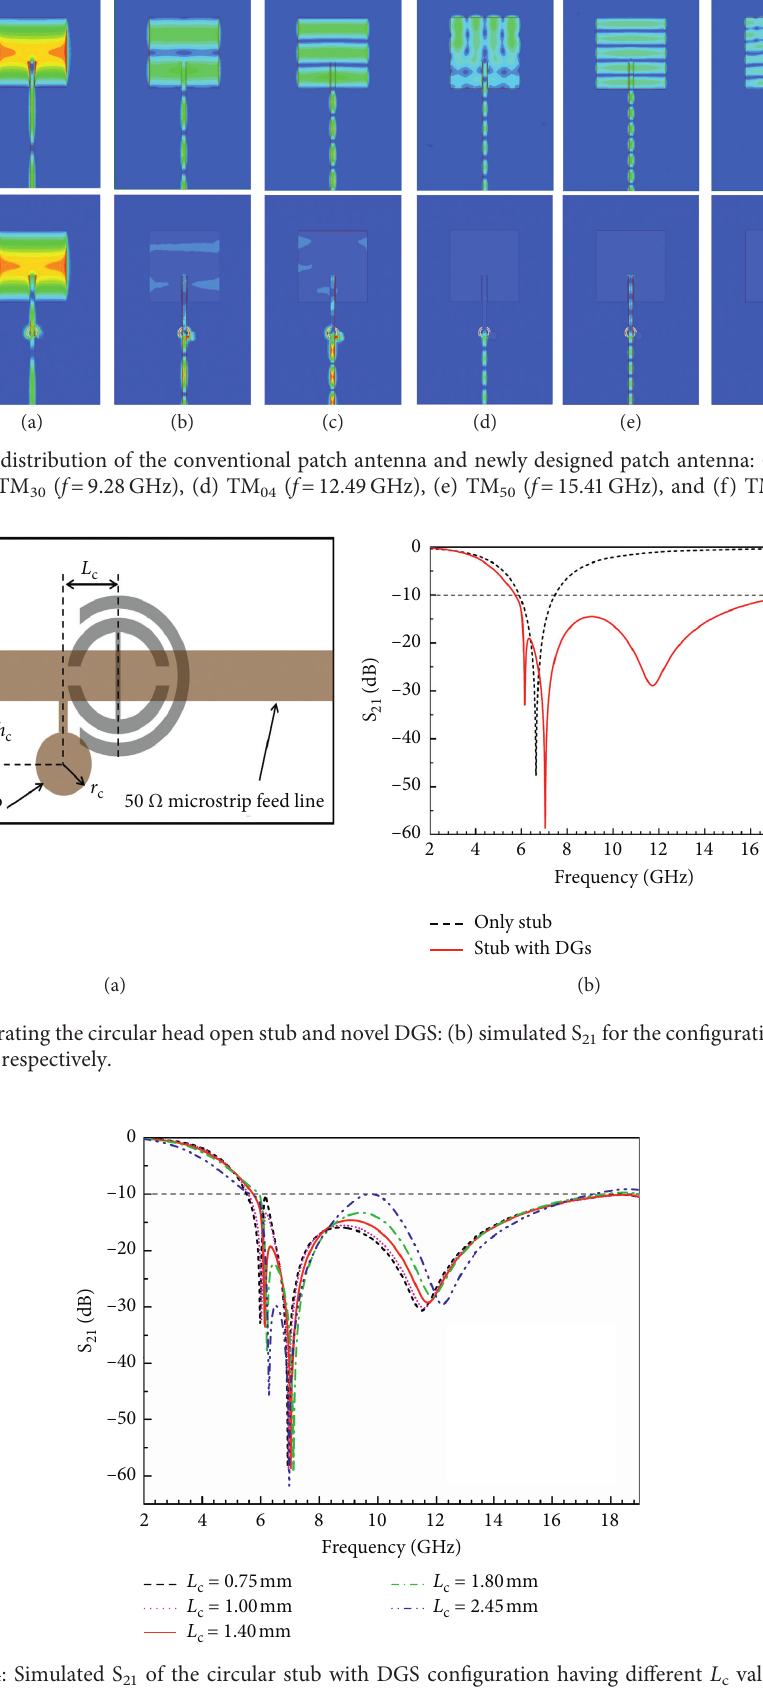
Figure 4: Simulated S 21 of the circular stub with DGS configuration having different L c